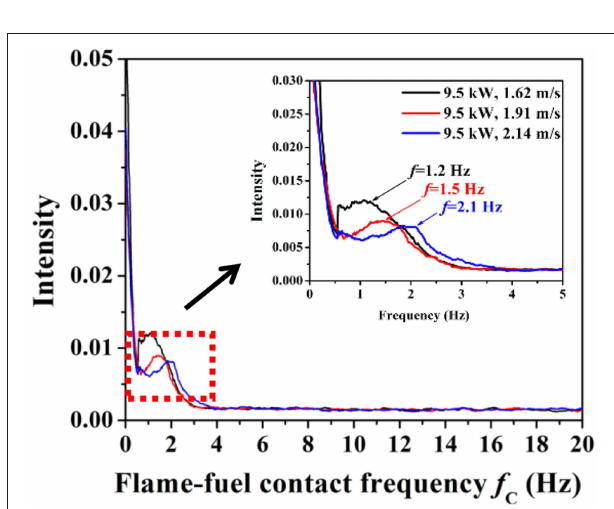
FIGURE 4 | Forward pulsation frequencies with different wind velocities and fire sizes.